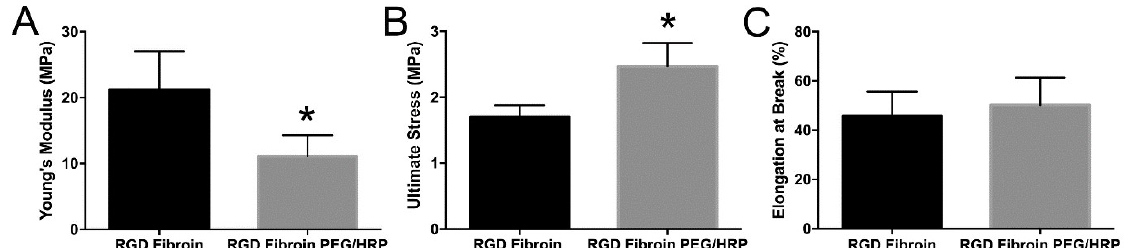
Figure 5. Evaluation of mechanical properties for freestanding RGD-Fibroin membranes when cast either with or without use of PEG as a porogen and the enzyme HRP as a crosslinking agent. ( A ) Young’s modulus, ( B ) Ultimate stress, and ( C ) Percentage elongation at break. All values are mean ± standard deviation of six measurements. Asterisk indicates significantly different value to RGD-Fibroin ( p < 0.01; non-paired two-tailed t test).